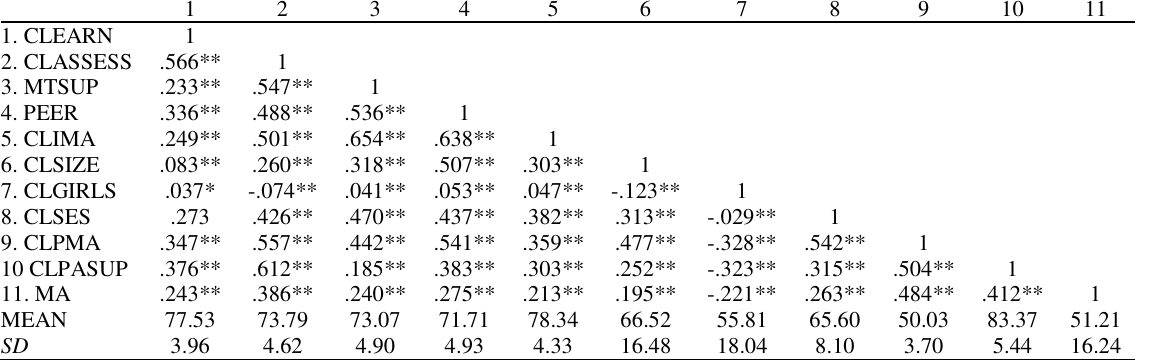
Table B2 Classroom-level predictors and mathematics achievement for the class sample ( N = 78) 1